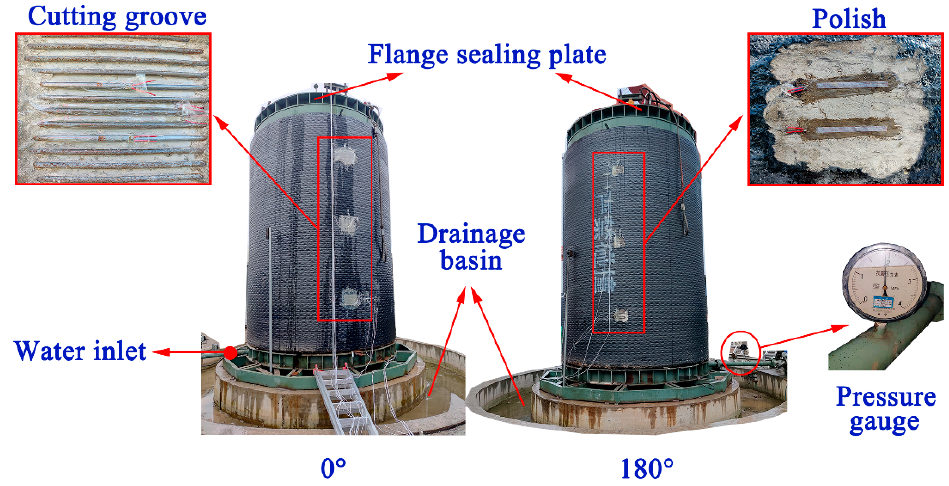
Figure 6. Internal water pressure test.